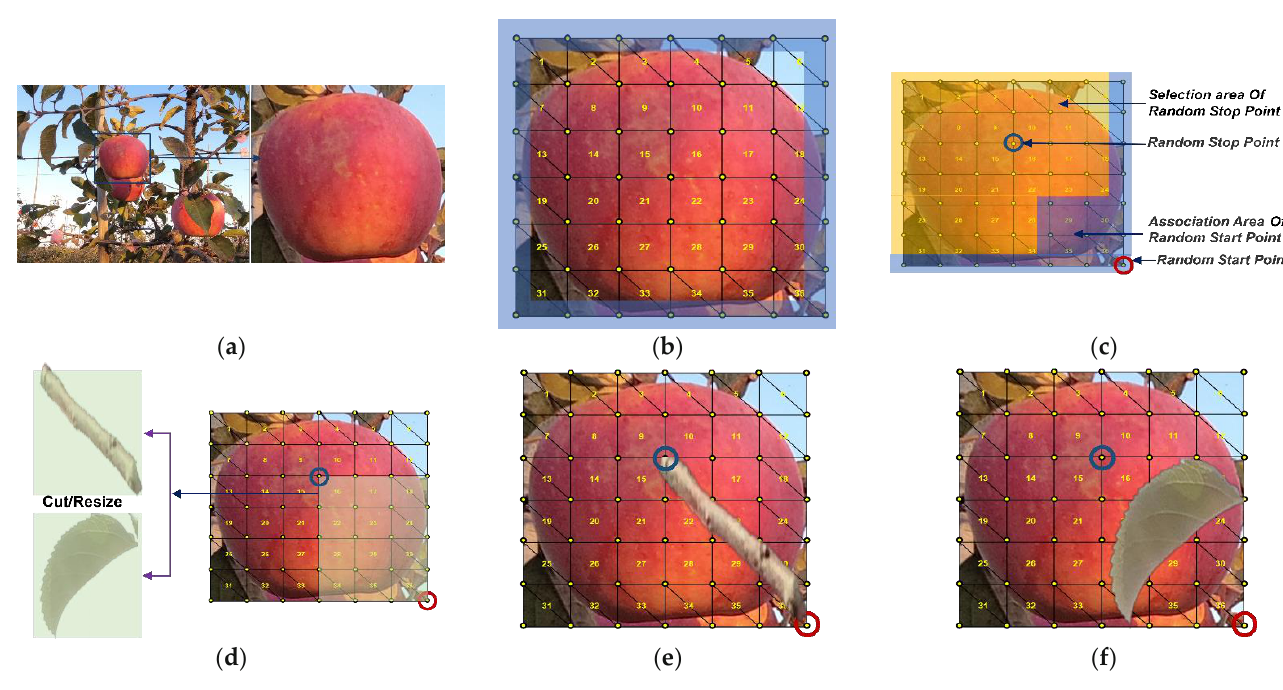
Figure 6. The synthesis process of B and L: ( a ) N is selected from the annotated images. ( b ) N area is gridded, and the blue part is the edge entry area. ( c ) The gridded area is divided into a random element insertion point selection area and a random element endpoint selection area, with the red point being the random starting point and the blue point being the random endpoint. ( d ) Branch or leaf occlusion elements are inserted between the random starting and random endpoints. ( e ) Synthetic B image; ( f ) Synthetic L image.